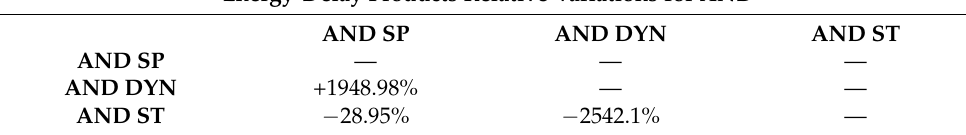
Table 7. Percentage differences in the AND energy-delay product among the arrays. Each value corresponds to the increase, expressed in percentage, in the energy-delay product of the memory on the corresponding row with respect to the one of the memory on the corresponding column. The data are extracted from Table 3. Energy-Delay Products Relative Variations for AND AND SP AND DYN AND ST AND SP — — — AND DYN +1948.98% — — AND ST − 28.95% − 2542.1%